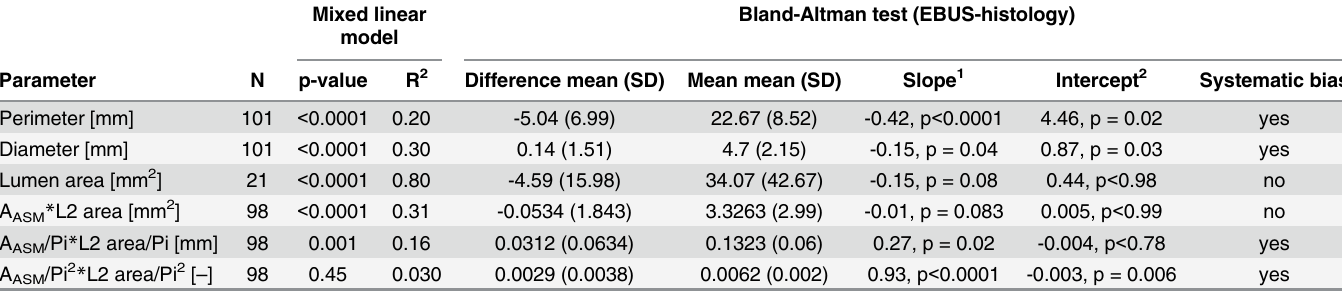
Table 3. Mixed linear models and Bland-Altman tests for comparison between EBUS and histologic